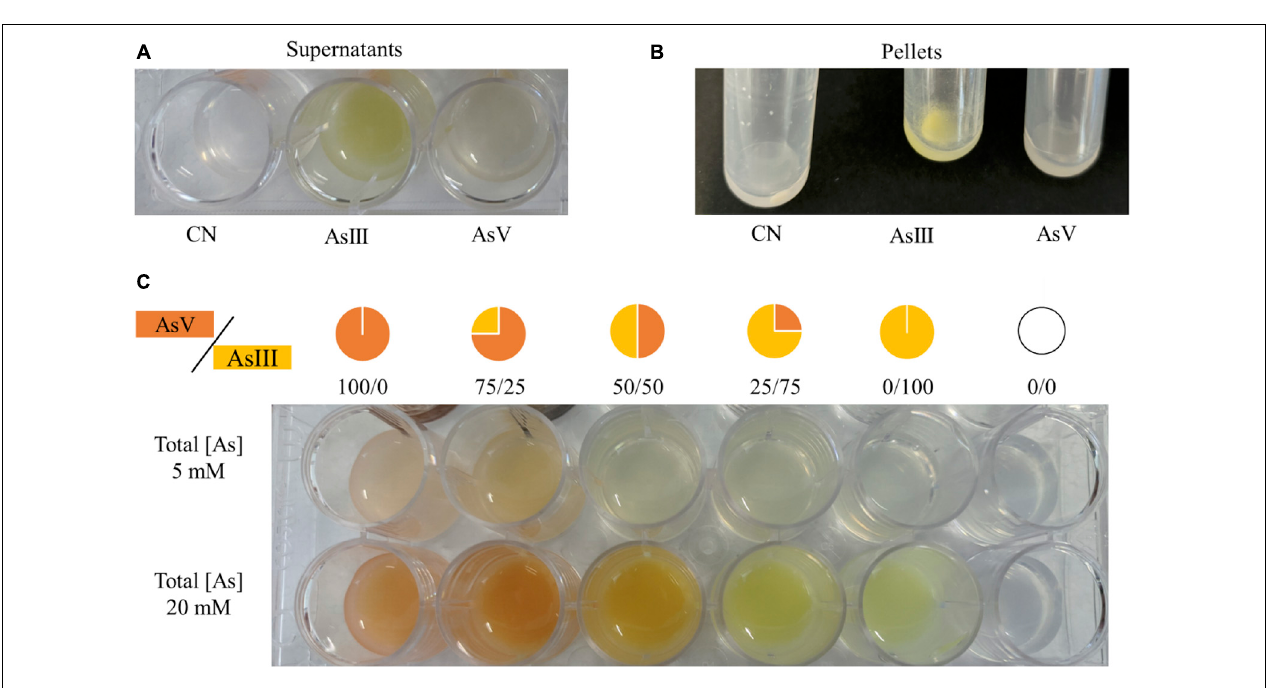
FIGURE 9 | Qualitative evaluation of arsenic biotransformation performed by A. mali FL18. The experiment was performed by reaction of AgNO 3 with (A) supernatants and (B) pellets of cells grown for 16 h in BAT medium (CN well) and in BAT medium supplemented with 20 mM As(III) or 5 mM As(V). (C) Color scales of different ratios of As(V)/As(III) in solutions with final arsenic concentrations of 5 and 20